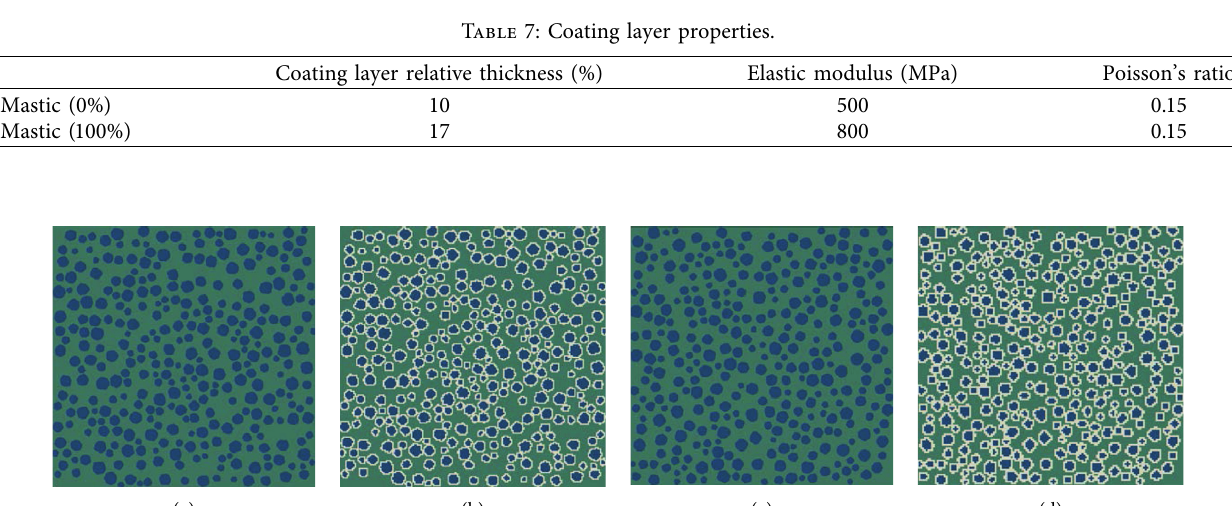
Figure 11: Microstructural models in the FE simulations. The microstructural model (a) without a coating layer for mastic (0%), (b) with a coating layer for mastic (0%), (c) without a coating layer for mastic (100%), and (d) with a coating layer for mastic